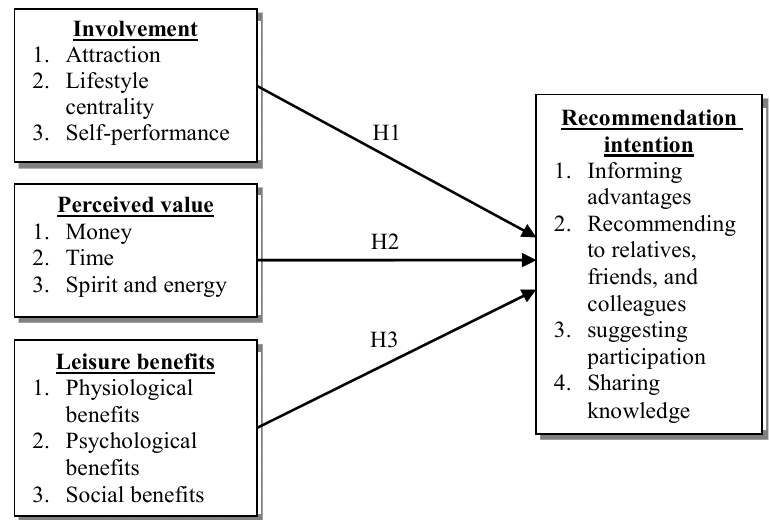
Figure 1. Research framework.